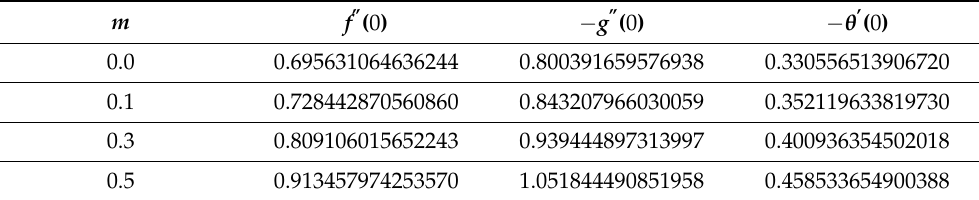
Table 1. Numerical results for f ” ( 0 ) , − g ” ( 0 ) and for − θ ’ ( 0 ) for variousvalues of m = 0.0,0.1,0.3,0.5, while other parameters are fixed.